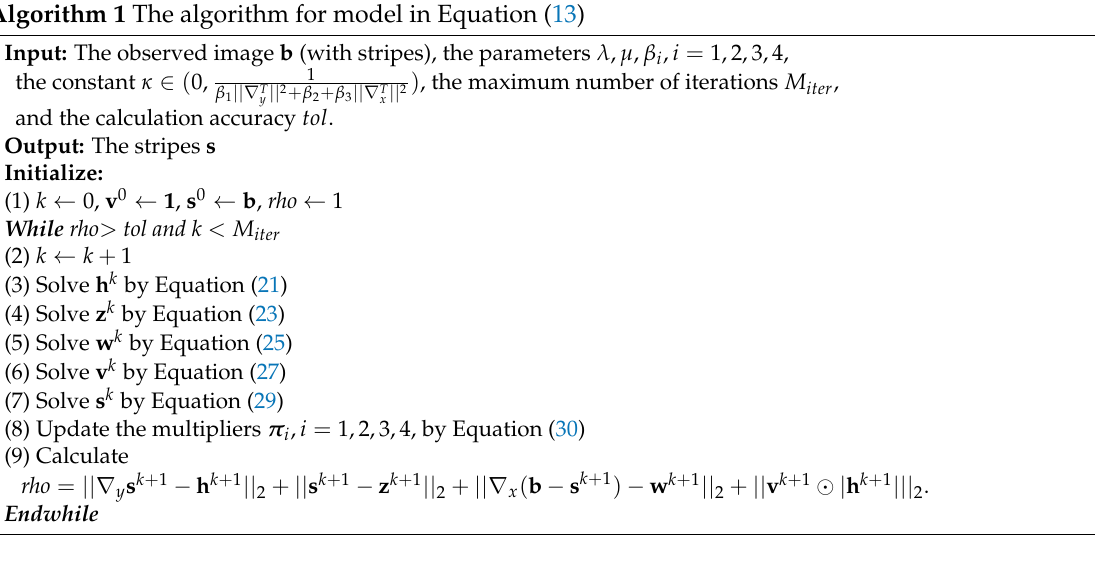
Algorithm 1 The algorithm for model in Equation